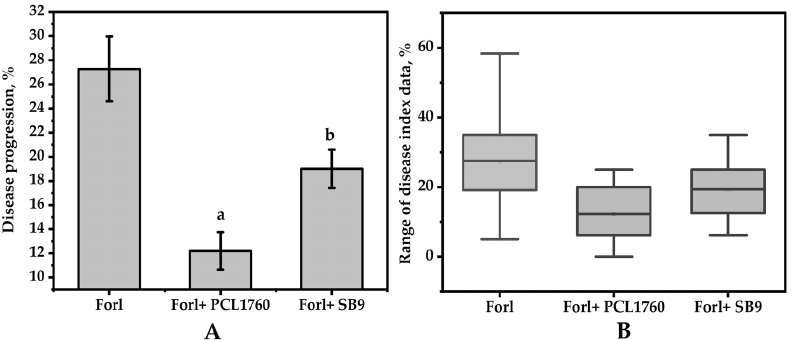
Figure 8. Biocontrol properties of P. putida SB9 in the suppression of tomato foot and root disease caused by Forl ZUM2407. ( A ) Disease index of each group (data are represented as mean ± SD) and ( B ) the range of the disease index data of tomato plants. Significant difference among groups at a p - value ≤ 0.05 is labeled with different letters ( a and b). Moreover, a statistically significant difference ( p ≤ 0.05 ) in the disease progression between groups pretreated with P. putida SB9 and the original strain of P. putida PCL1760 was observed (Figure 8). The DI of plants pretreated with the original strain PCL1760 was recorded as 12.20 ± 1.55%. The effectiveness of P. putida SB9 and PCL1760 to inhibit the growth of Forl ZUM2407 was calculated as 30.24 ± 5.79% and 55.28 ± 5.68%. 4. Discussion Pseudomonas strains as biocontrol agents are known to be better colonizers in com- parison to their Bacillus counterparts, although several strains of both genera are known to produce secondary metabolites that are involved in direct antibiosis of phytopatho- genic fungi taking into consideration P. putida [2,28,29]. Among biocontrol agents, Pseu- domonas strains are known to be of best colonizers due to their developed motility appa- ratus and wide range of utilized substrates, covering all major compounds of plant root exudates [30]. Both abilities–motility and efficient nutrient consumption are constituents of the CNN mechanism of biocontrol, referred also as competitive colonization [4]. Under natural conditions, root plants are colonized with a variety of microorganisms, which dif- fer greatly in motility, and a set of consumed compounds [31]. This might imply persis- tence as an additional important constituent of the competitive colonization mechanism. Persistence to environmental stresses in eubacteria is governed by a stringency re- sponse system. Being part of the stringency response ribosome hibernation genes are fre- quently located within starvation operons and are mostly expressed in the stationary phase of bacterial growth [32,33]. The ribosome silencing factor ( rsfS ) is a conserved gene found in bacteria and eukaryotic organelles [14]. Based on the data published on the mech- anism of hibernation, RsfS is a key gene in ribosomal hibernation [16,34,35], and the reason that it was chosen was to confirm persistence in our root colonizer P. putida PCL1760. Recent work on PCL1760 showed its susceptibility to ceftriaxone, which inhibits cell wall synthesis [9,36]. Thus, in this study, only dividing cells are susceptible to death in the